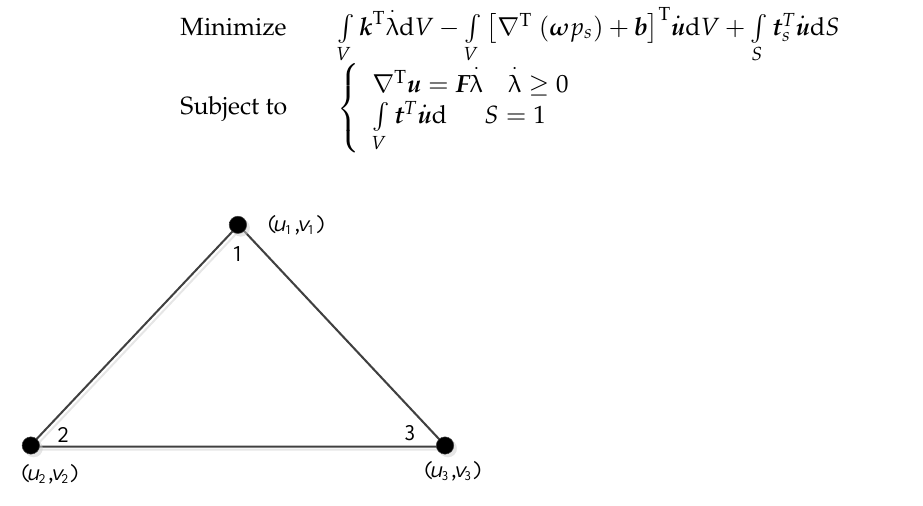
Figure 2. The upper bound element.